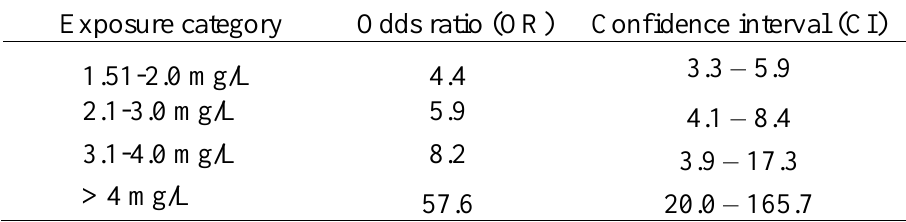
Table 4. The risk of dental fluorosis in relation to different fluoride